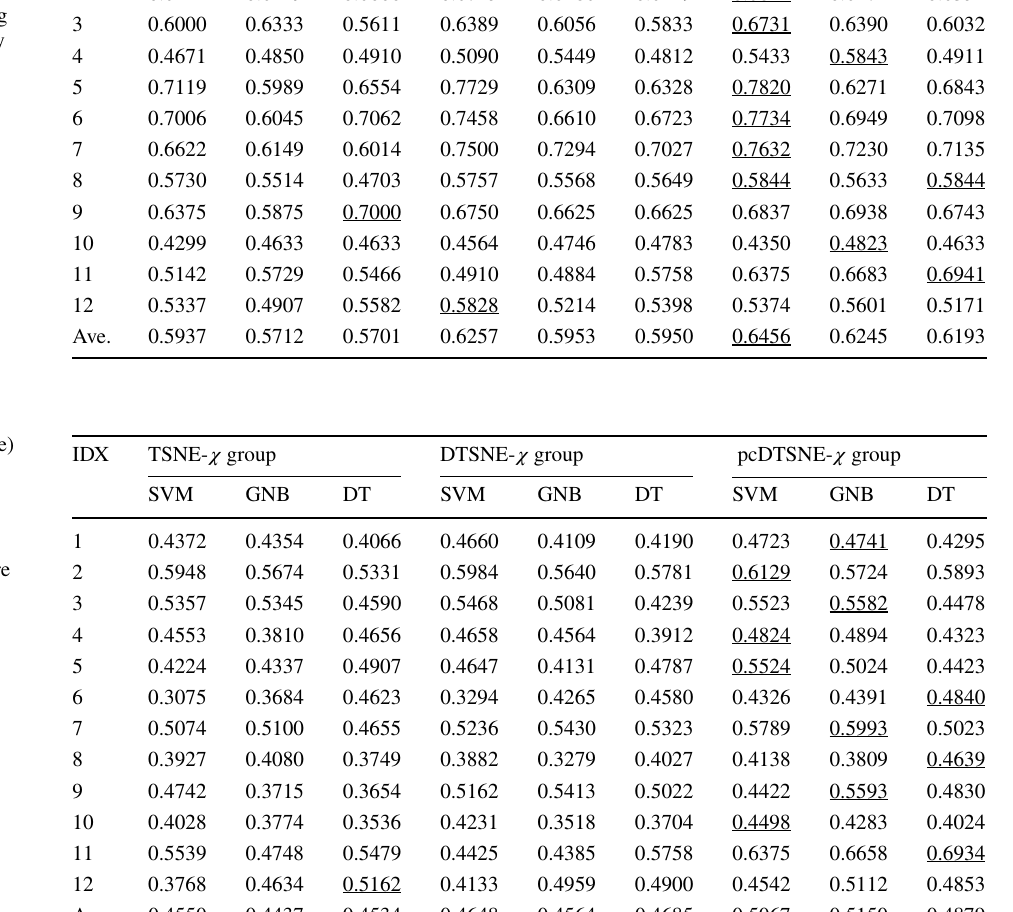
Table 4 Performance (accuracy) comparison of TSNE- 𝜒 group, DTSNE- 𝜒 group and pcDTSNE- 𝜒 group for classification task over twelve datasets, and the highest score for each datasets among nine algorithms is denoted by underline font